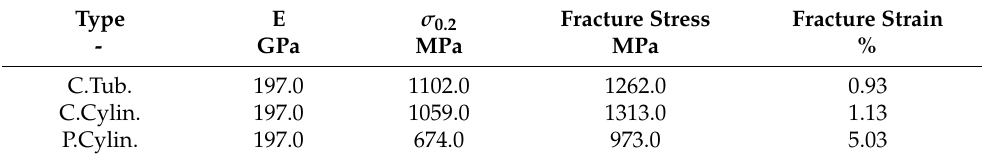
Table 1. Tensile properties of the